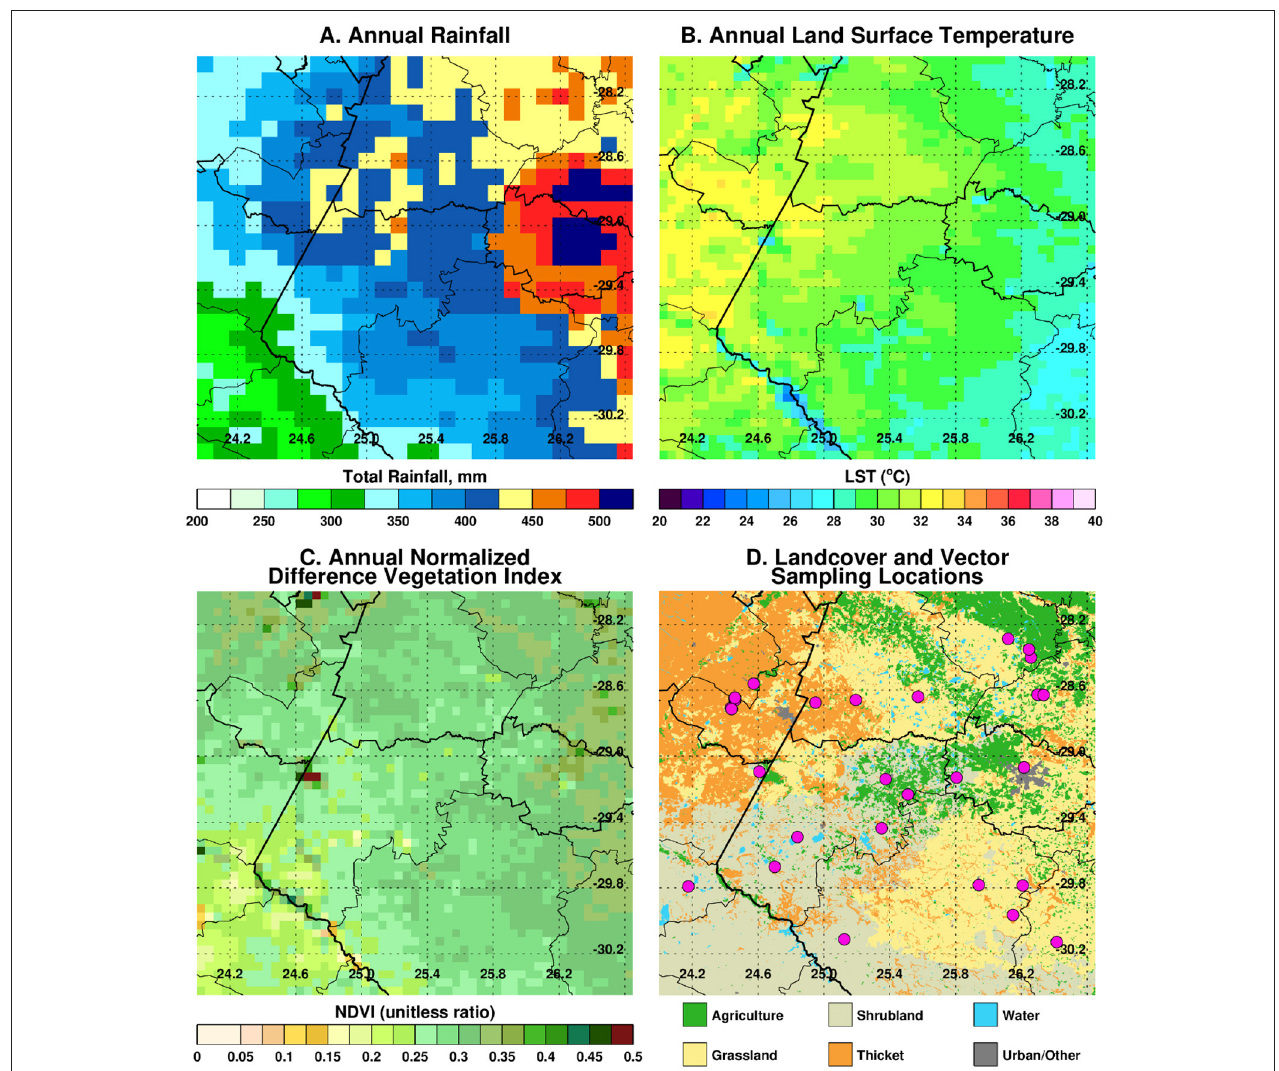
FIGURE 2 | Climate metrics and land cover characteristic of the study region. In (A) annual long-term rainfall (1983–2019), (B) annual long-term land surface temperature (2000–2019), (C) annual long-term normalized vegetation index (2000–2019), and (D) land cover classification. The spatial variations and patterning in (B–D) to a large extent reflect the patterns in long-term